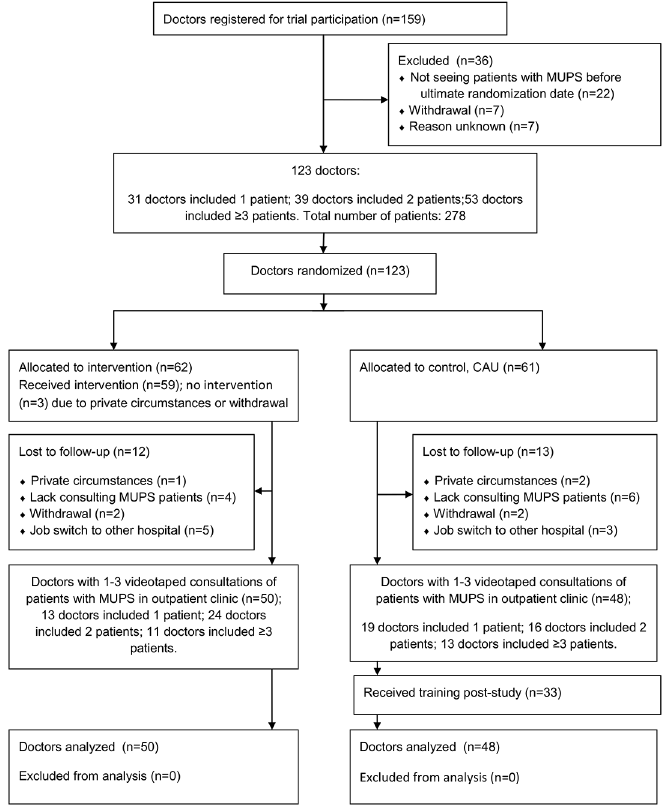
Fig 1. Consort Flow Chart. This figure shows the amount of eligible and included doctors throughout the study accompanied by the amount of videotaped patients per doctor in pre-and post-measurements.